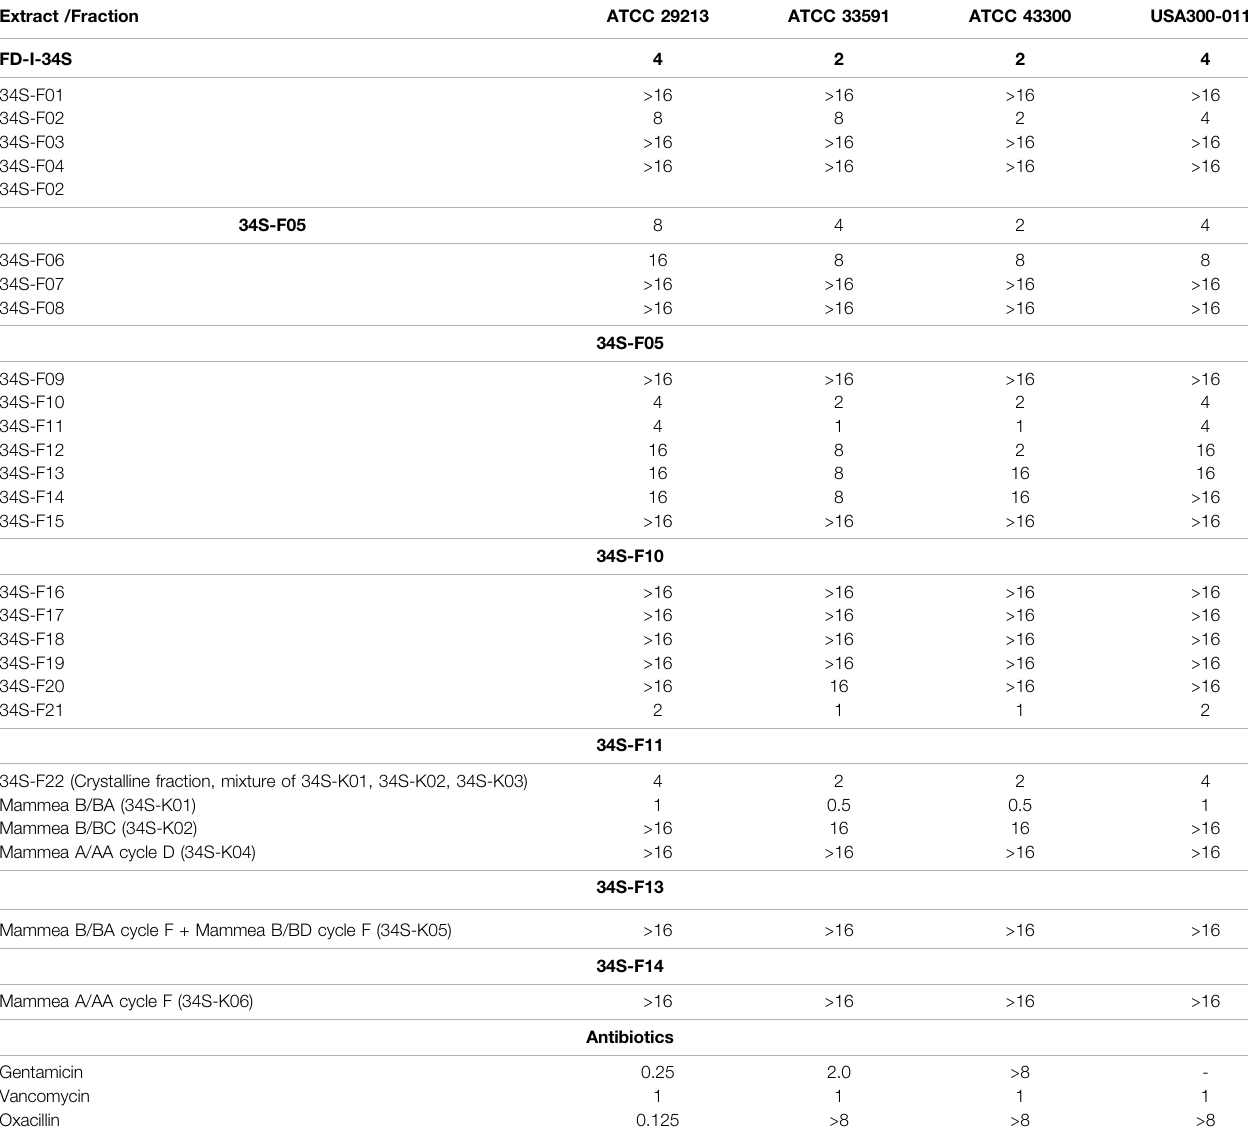
TABLE 1| Minimuminhibitory concentration (µg/ml)oftheextract(FD-I-34S),fractions,and compounds isolatedfromthe seedsof M.americana againstATCCstrains of S. aureus sensitive (ATCC 29213) and resistant to methicillin (ATCC 33591, ATCC 43300, and USA300-0114). Extract